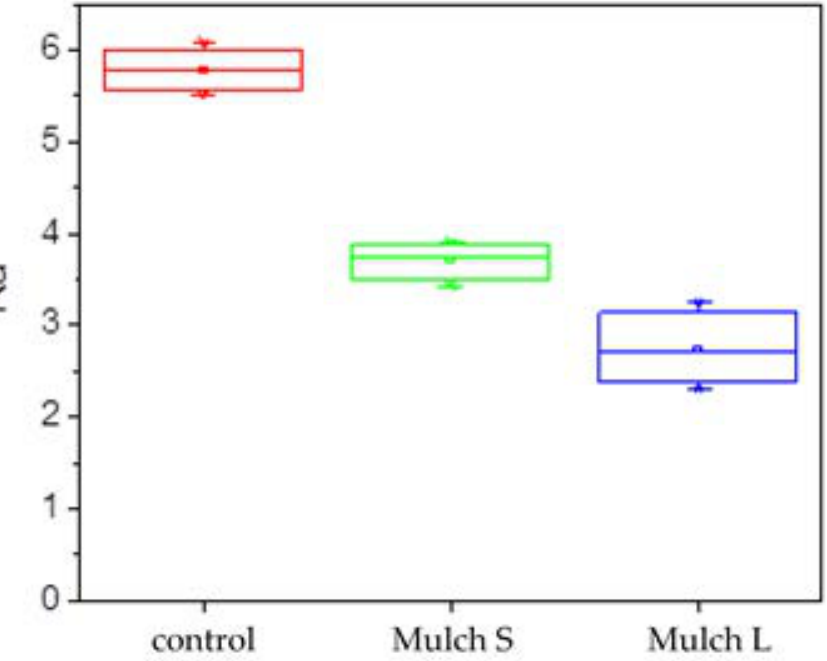
Figure 3. Compared kinetics of appearance (Ra) of Lepidium sativum seedlings at 6 days post imbibition through 5 cm layer of hemp and mulches prepared with leaves collected in May from trees facing north (S) or exposed to solar light (L). Mean values of four replicates ( ± standard